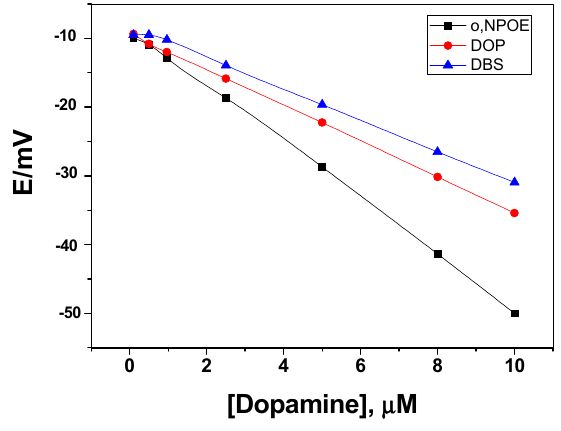
ff ect of plasticizers on the membrane Figure 4. Effect of plasticizers on the membrane response. Figure 4. E